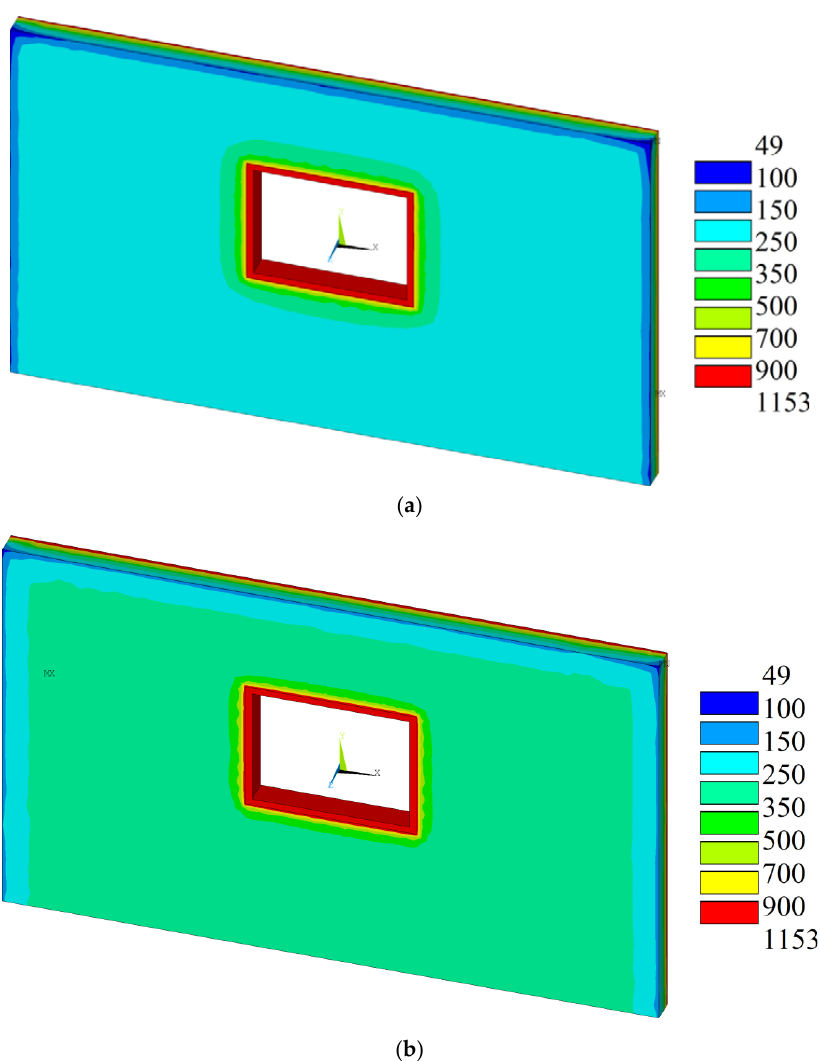
Figure 14. Analysis results for the W1B specimen, including an aluminum window frame, and considering ( a ) 120 min and ( b ) 240 min of